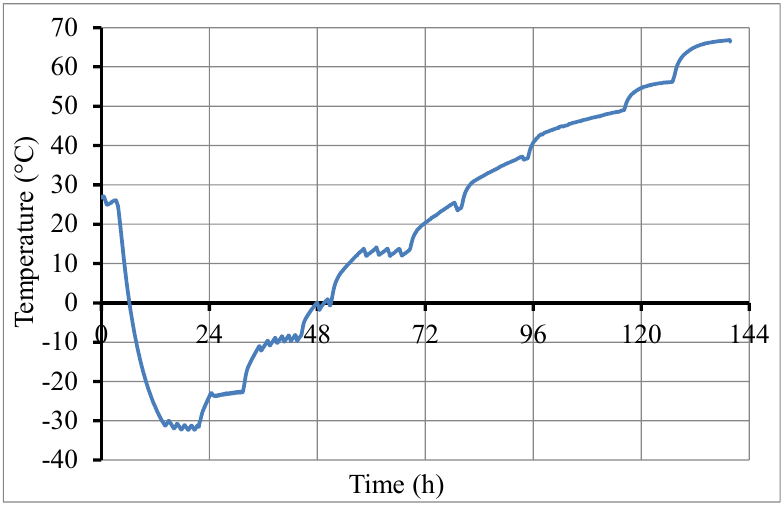
Figure 2. Typical Thermal cycles measured at FRP bar/concrete interface.